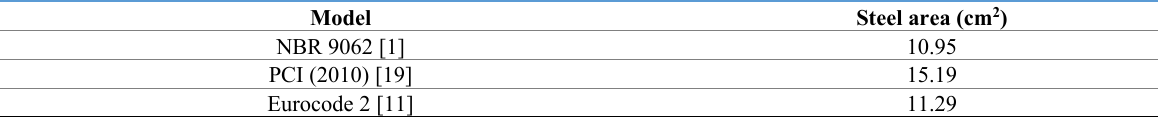
Table 5. Reinforcement areas of the main